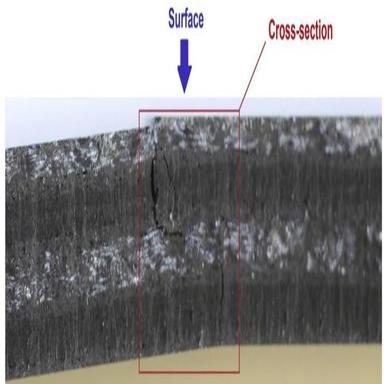
Locations analysed by SEM for the fracture arising from the flexural tests.